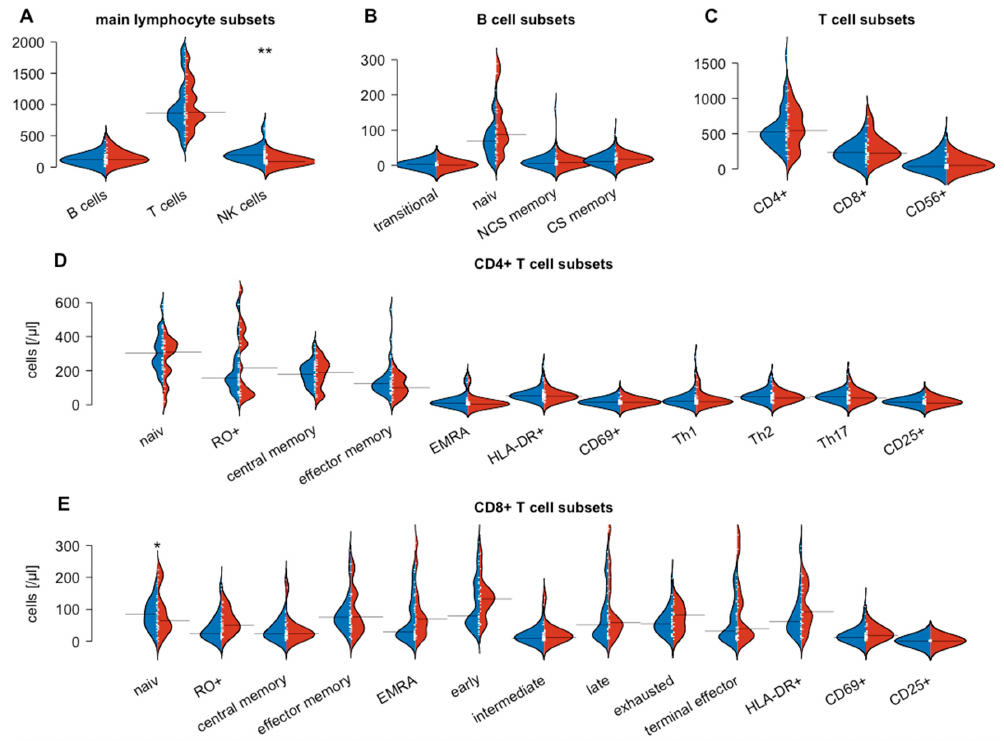
Figure 2. Comparison of lymphocyte subsets between SARIFA-positive (red) and SARIFA-negative (blue) CRC patients: Main lymphocyte subsets ( A ), B cell subsets ( B ), T cell subsets ( C ), CD4+ T cell subsets ( D ), CD8+ T cell subsets ( E ). Small white lines indicate individual data points; large black lines show the overall subset average of SARIFA-positive and SARIFA-negative CRC patients, respectively. * p < 0.05, ** p < 0.01.